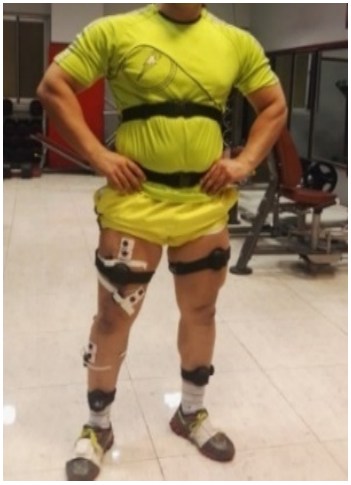
Figure 1. Noraxon’s myoMotion and myoMuscle sensor location.